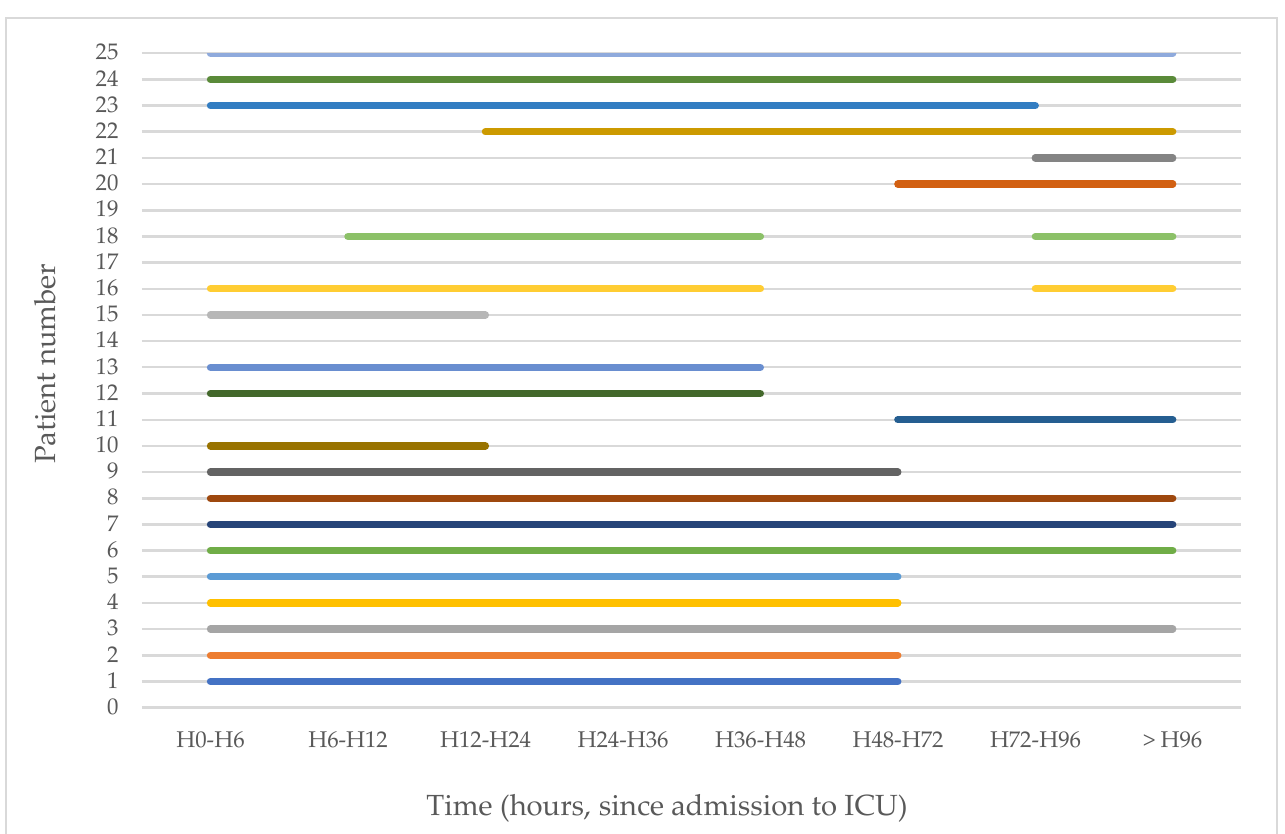
Figure 2. Distribution over time of aEEG recordings for each patient (1 – 25). Patients 14, 17, and 19: aEEG was recorded beyond H96 of hospitalization in ICU.